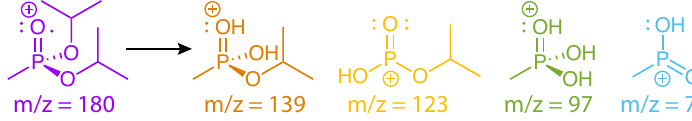
Figure 5. ( a ) Transient signals of ions from DIMP: DIMP · + ( m / z = 180, violet, magnified by a factor of 10), PO 3 C 4 H 12+ ( m / z = 139, orange), PO 3 C 3 H 8+ ( m / z = 123, gold), PO 3 CH 6+ ( m / z = 97, green), and PO 2 CH 4+ ( m / z = 79, blue). The dark solid lines denote fits to Equation (1). ( b ) Residual ion signals after exponential dynamics subtracted. ( c ) FFT of residual PO 3 C 4 H 12+ , PO 3 C 3 H 8+ , and PO 3 CH 6+ ion signals in ( b